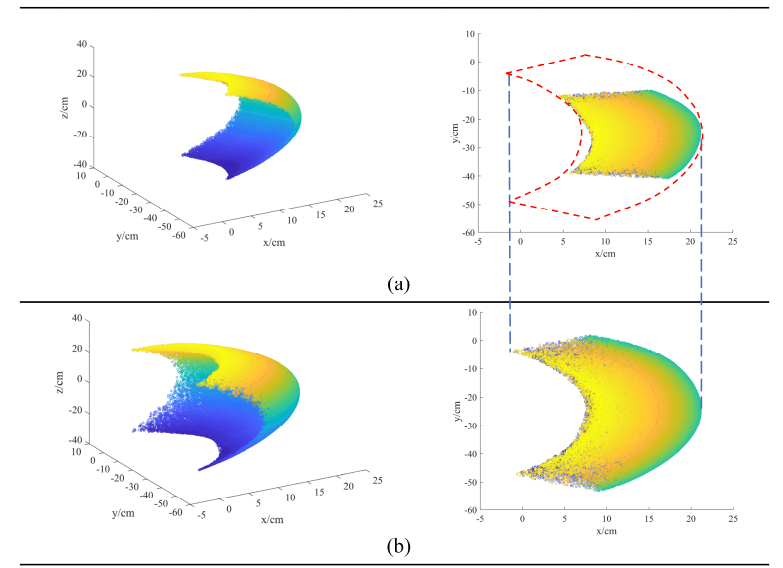
Figure 4. Changes in foot workspace: ( a ) Rigid trunk; ( b ) Flexible waist.